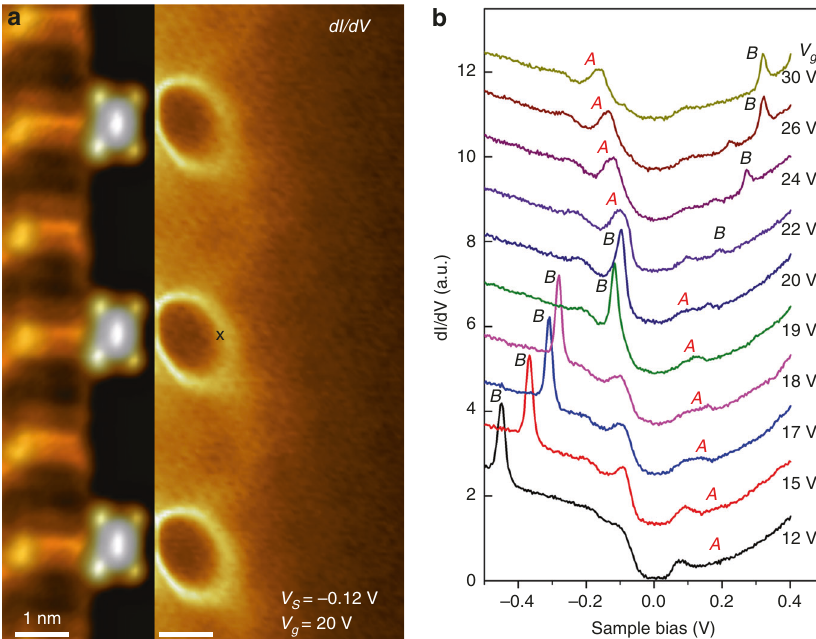
Fig. 3 Gate-dependent charging behavior of supercritical quasi-bound state. a Left side: STM image of a portion of a charged 2 a F 4 TCNQ array. Right side: d I/ d V map of the pristine graphene region adjacent to the array shows charging rings in the near- fi eld region ( V g = 20 V, V S = − 0.12 V). b Gate-dependent d I /d V spectra acquired at the position marked “ x ” in panel ( a ). The supercritical resonance is labeled “ A ” , and the corresponding tip-induced charging/ discharging feature is labeled as “ B